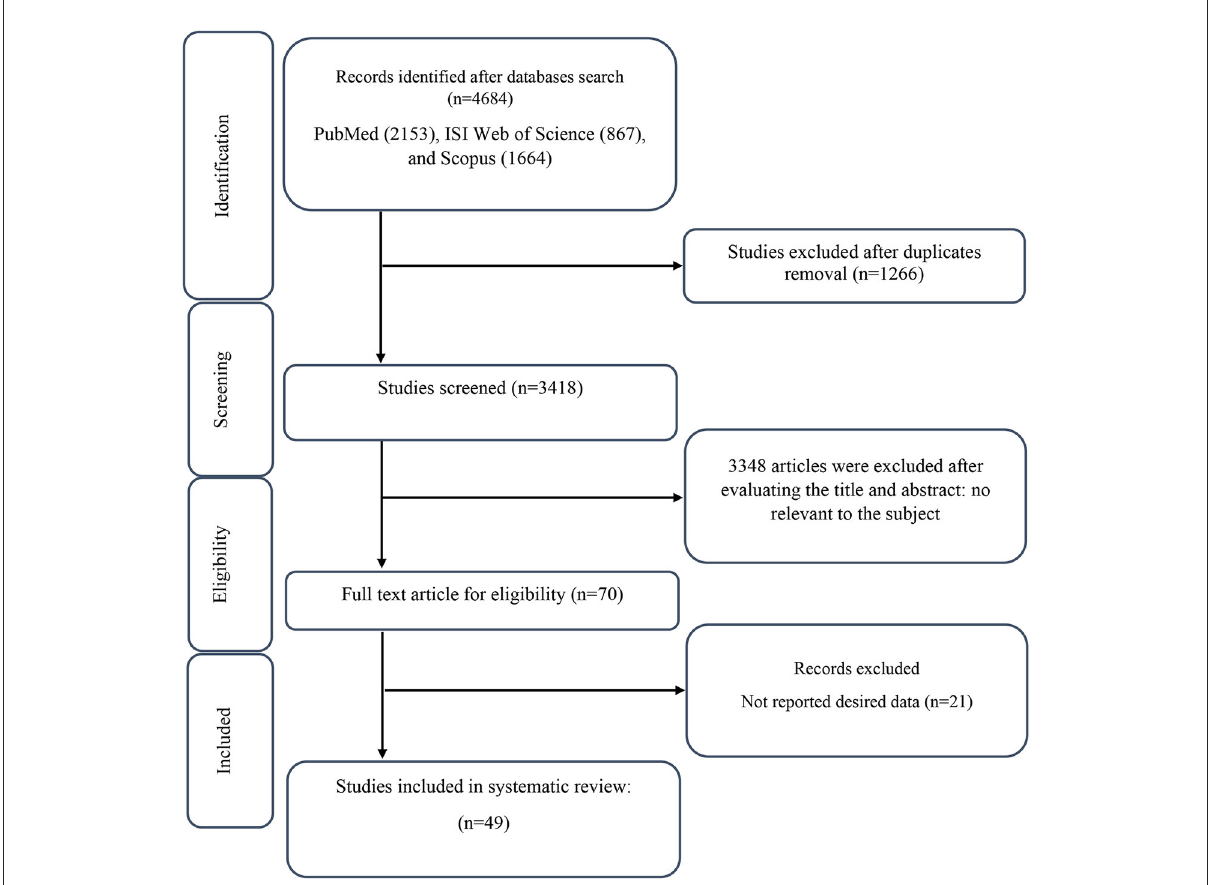
FIGURE1 Flow chart of study selection for inclusion trials in the systematic review.